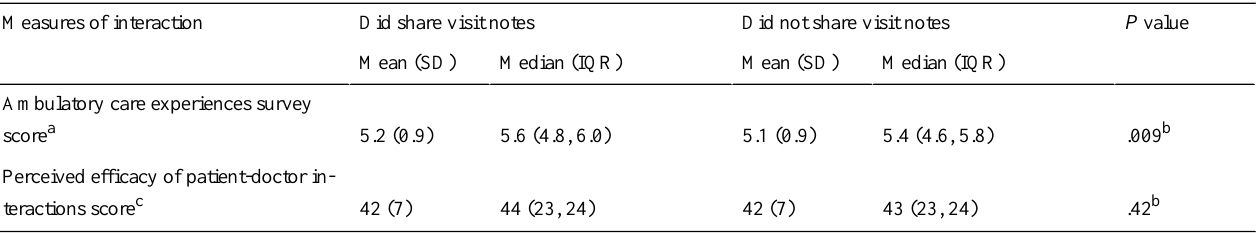
Table 2. Patient-doctor interaction and patient confidence in communication with doctor scores for patients who did share or did not share visit notes with someone else during the study.